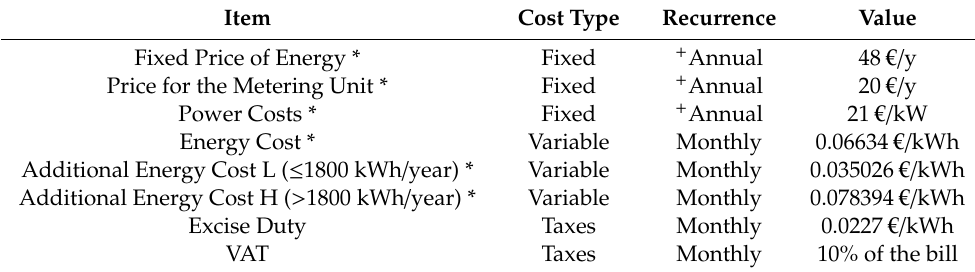
Table 9. Costs of the electrical bill identifying fixed and variable